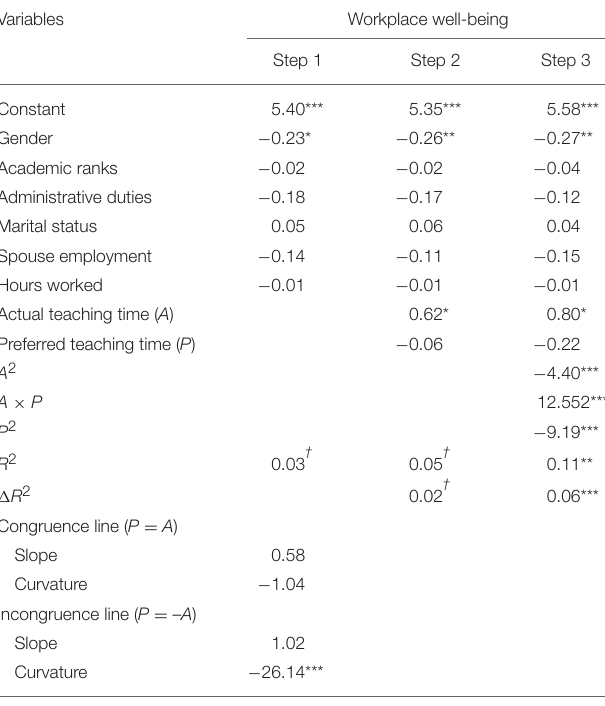
TABLE 5 | Polynomial regressions of workplace well-being on teaching time allocation. Variables